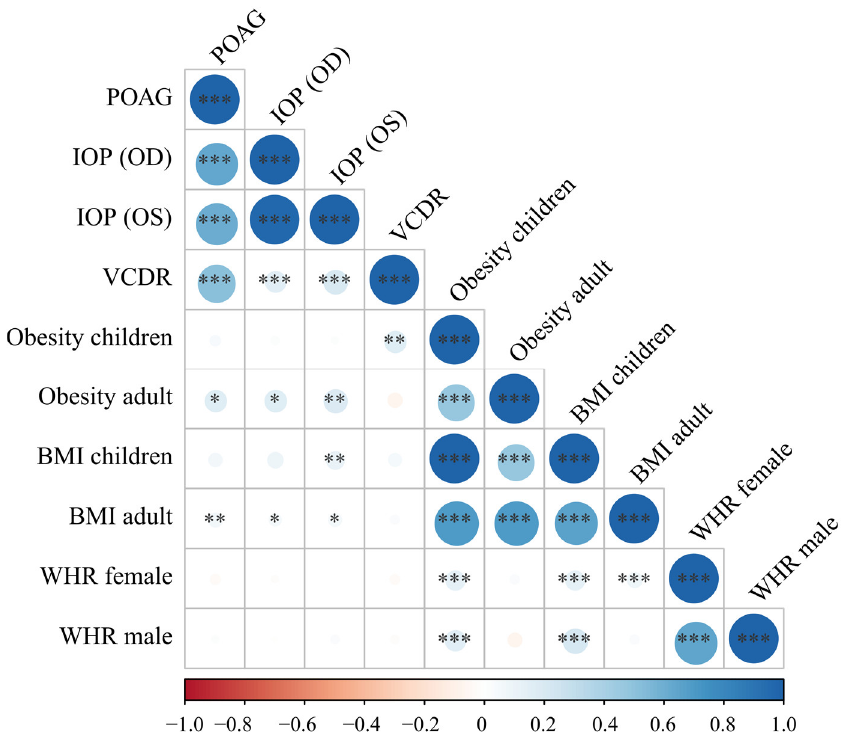
Figure 2. Genetic correlations of primary open-angle glaucoma-related phenotypes and body fat measurements. Obesity and BMI were positively correlated with POAG, IOP, and VCDR with suggestively significant p values. Glaucoma phenotypes and body fat measurements showed strong genetic correlations within their own cluster, which suggested that the genetic correlation results were valid and robust. The larger the correlation coefficient’s absolute value was, the larger the circle. The direction and value of the correlation coefficients were indicated by the color bar below the plot. BMI, body mass index; IOP, intraocular pressure (corneal-compensated, OD and OS); OD, right eye; OS, left eye; POAG, primary open-angle glaucoma; VCDR, vertical cup-to-disc ratio; WHR, waist-to-hip ratio * p < 0.05, ** p < 0.01, *** p < 0.001.